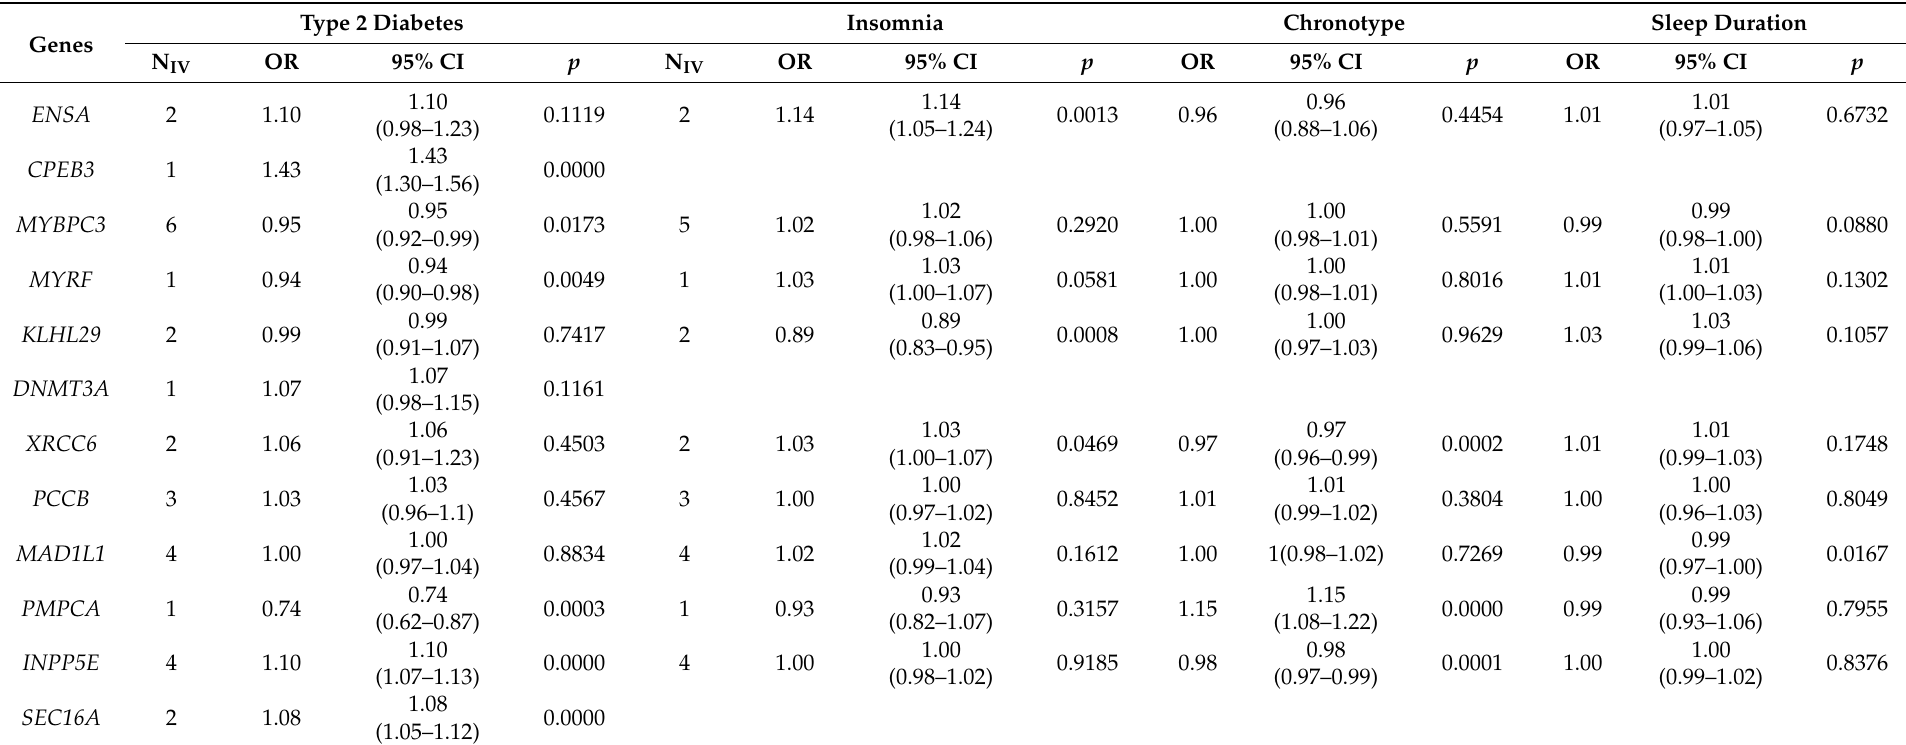
Table 2. Causal relationship between gene expression and type 2 diabetes, insomnia, chronotype, and sleep